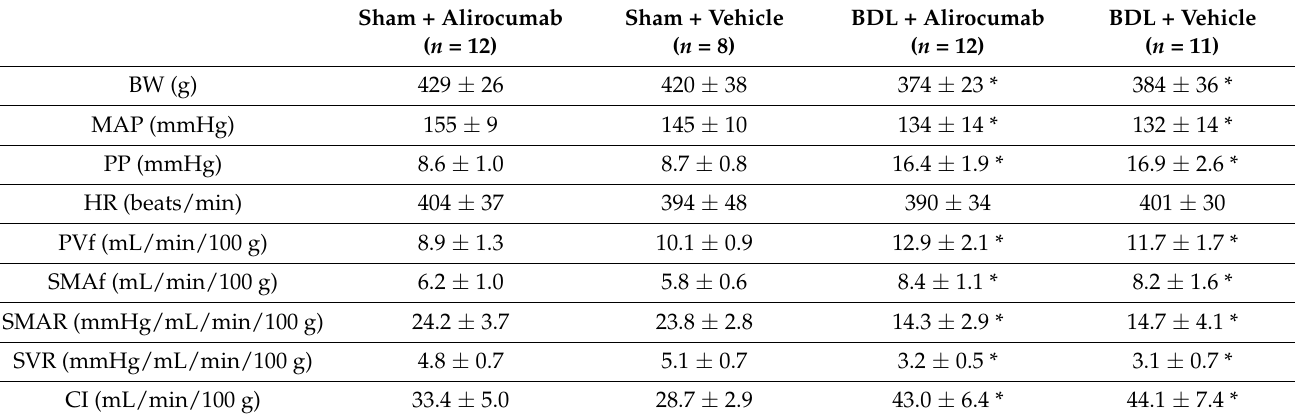
Table 1. Hemodynamic parameters of sham-operated or BDL rats with or without alirocumab treatment. Sham + Alirocumab Sham + ( n = 12)